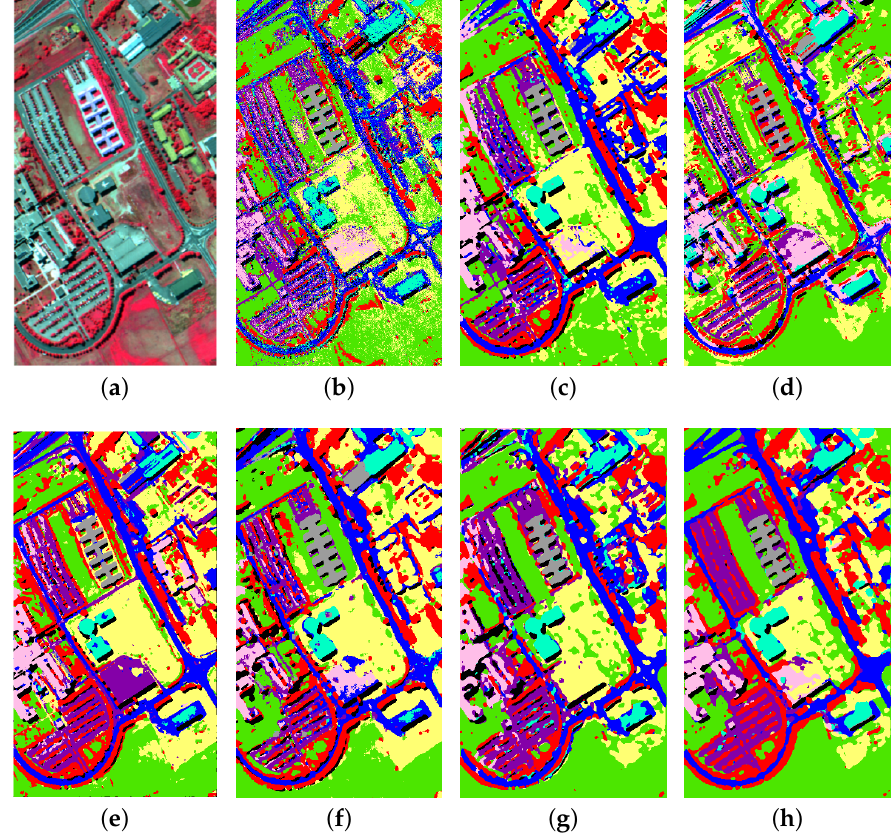
Figure 11. Classification maps predicted by different methods for PaviaU dataset. ( a ) Ground-truth, ( b ) 3-D CNN (78.01%), ( c ) SSRN (88.58%), ( d ) SSUN (84.49%), ( e ) S-DMM (92.02%), ( f ) CNN-AL-MRF (91.50%), ( g ) DLSN (92.70%), ( h ) ALSN